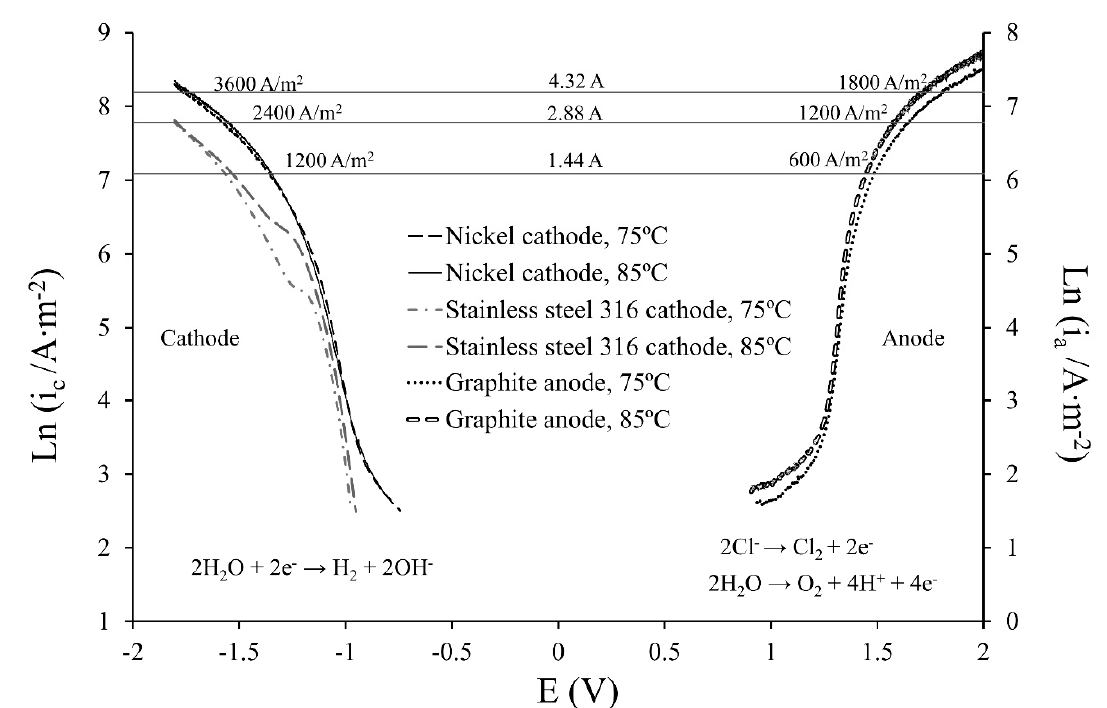
Figure 6. Kinetics of oxidation (Cl − / Cl 2 and H 2 O / O 2 ) and reduction kinetics (H 2 O / H 2 ) using nickel, stainless steel 316 and graphite at 75 °C and 85 °C.